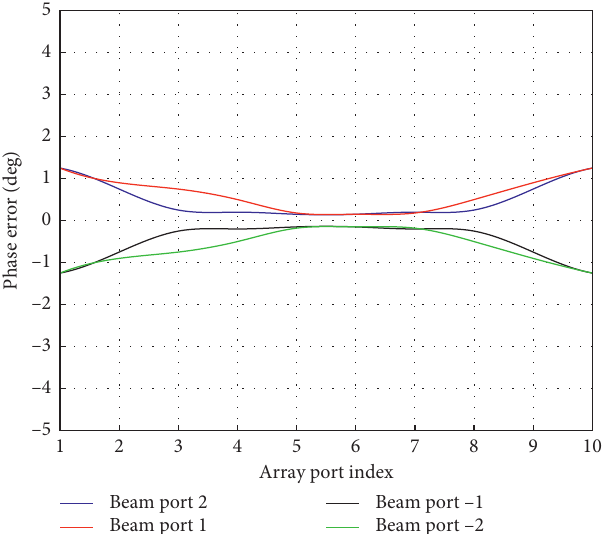
Figure 14: C-band Rotman lens: phase errors at the array ports.